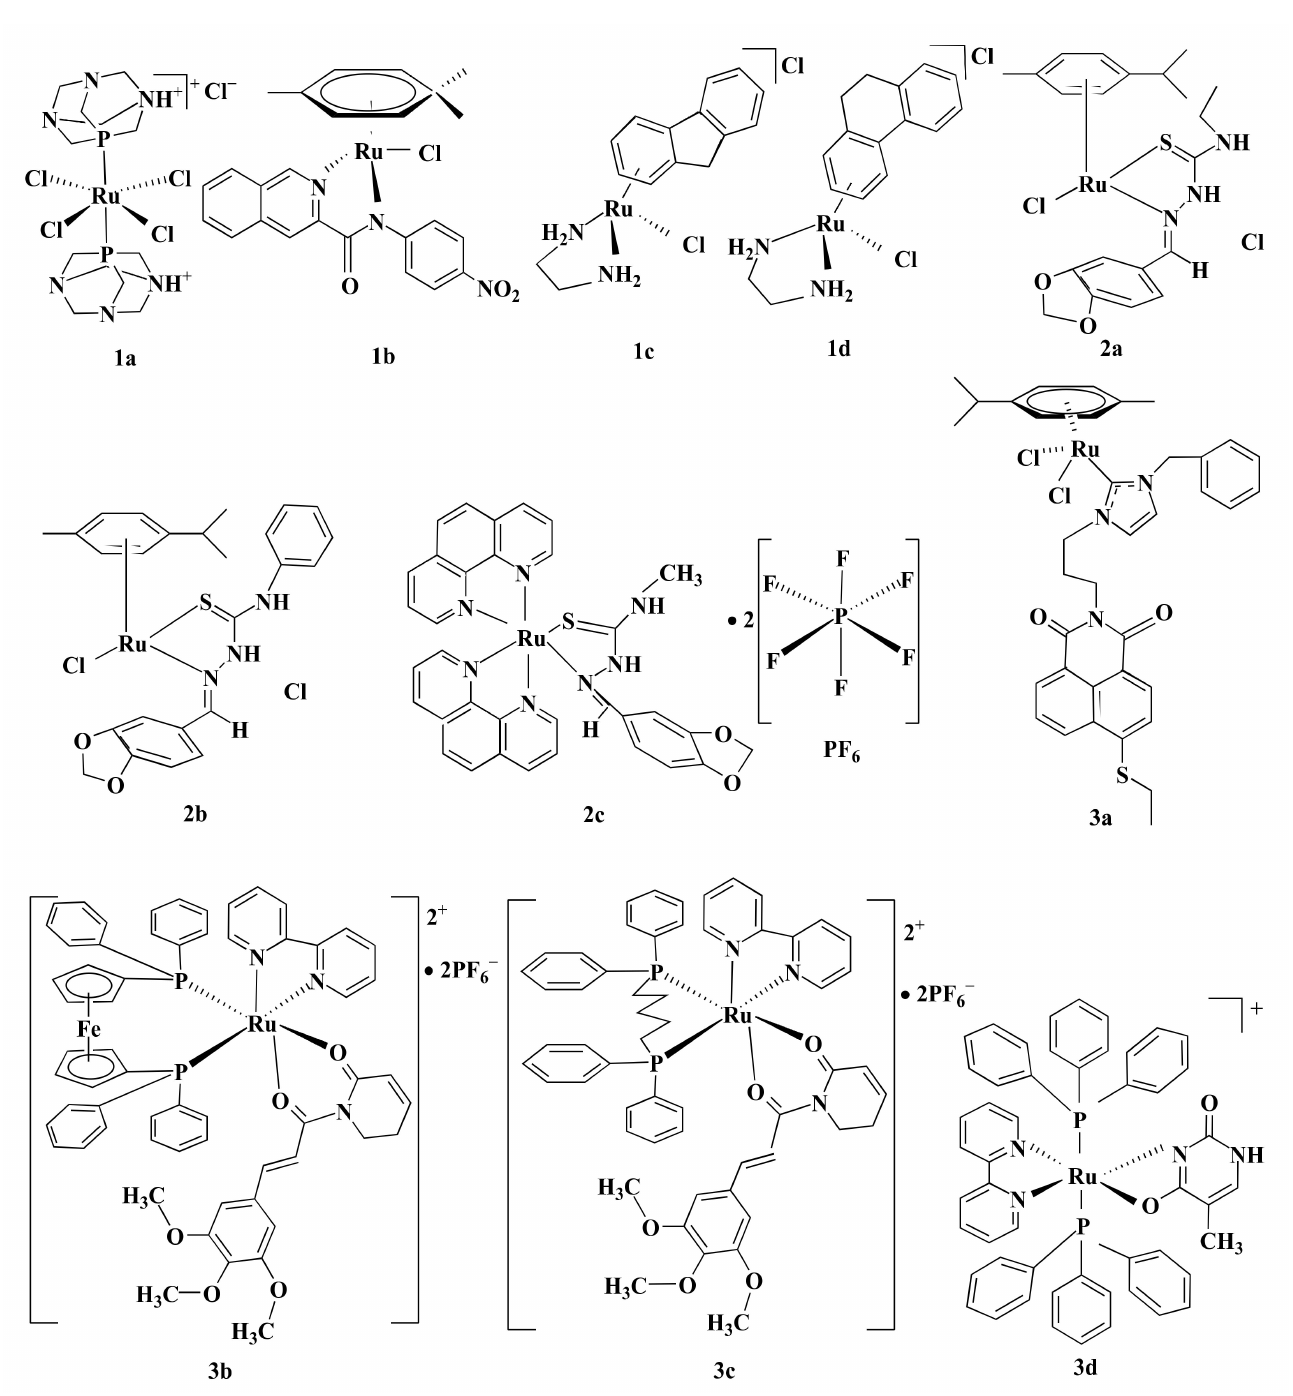
Figure 4. Schematic representation of some Ru-based drug candidates. Different Ru-complexes mediated CRC cells apoptosis through DNA damage ( 1a – d ), inhibiting DNA topoisomerase II enzyme ( 2a – c ), and regulating MAPK signaling pathway ( 3a – d